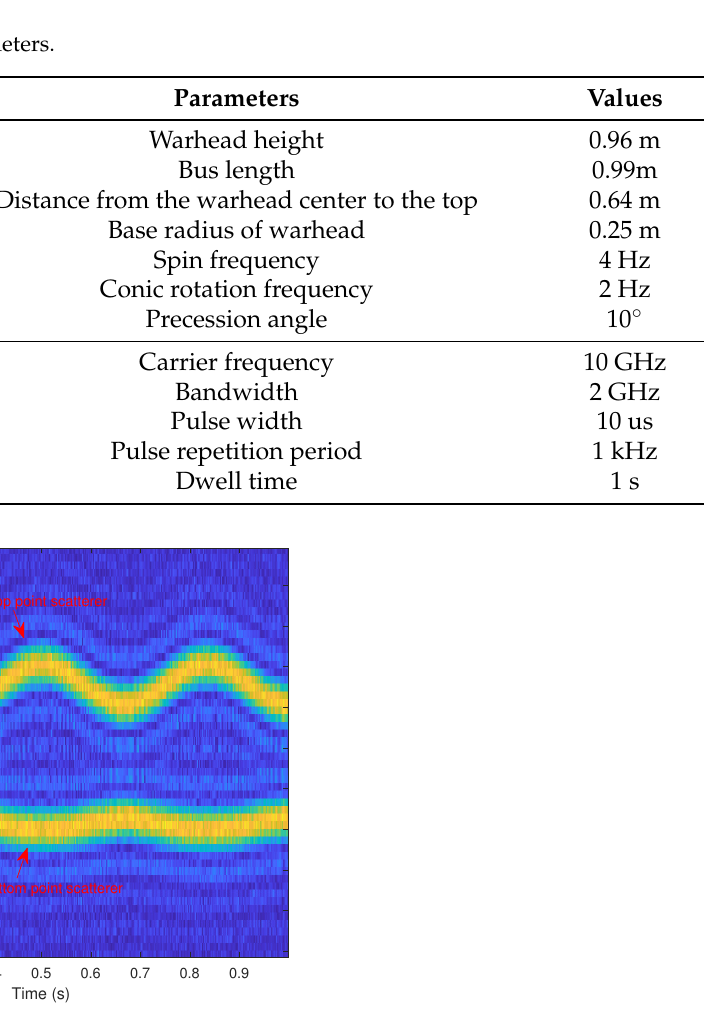
Figure 4. HRRP sequence. Take SNR = − 15 dB as an example for presentation the HRRP